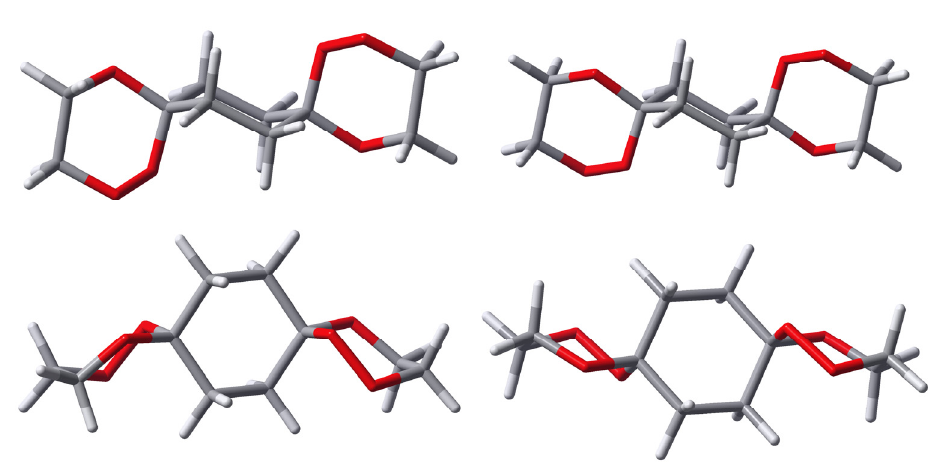
Figure 4 . Calculated structures of anti - 9 (OO) Each conformer is shown from two perspectives (upper and lower